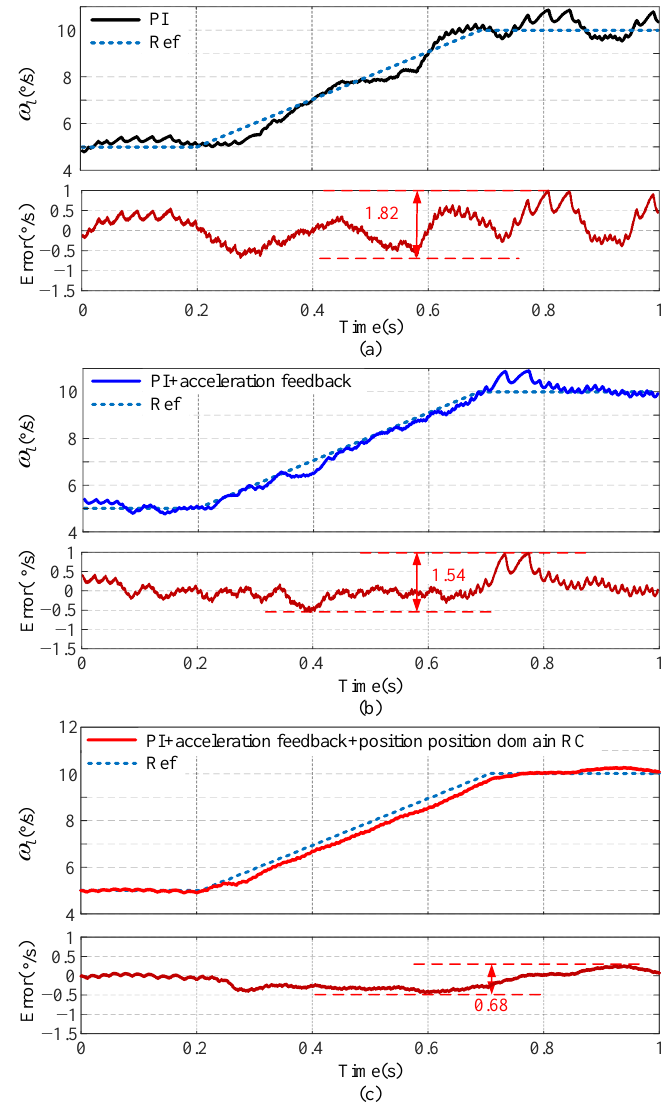
Figure 14. Experimental results of load angular speed and tracking error at variable speed motion: ( a ) PI; ( b ) PI+acceleration feedback; ( c ) PI+acceleration feedback+position domain